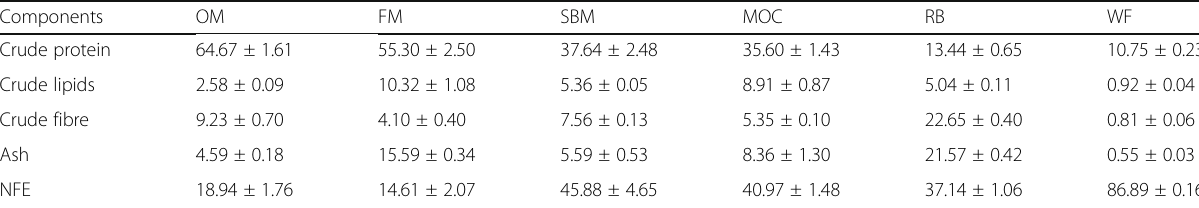
Table 1 Proximate composition of feed ingredients (% of dry matter)